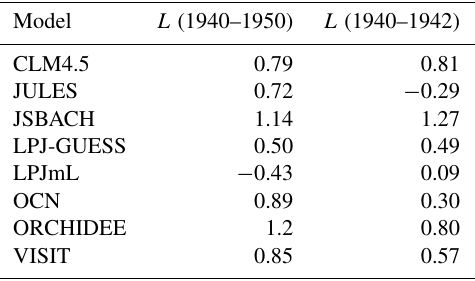
Table 2. Terrestrial sink during the plateau period (1940–1950) and during the El Niño event of 1940–1942, estimated by the set of DGVMs. Values are in PgCyr − 1 .